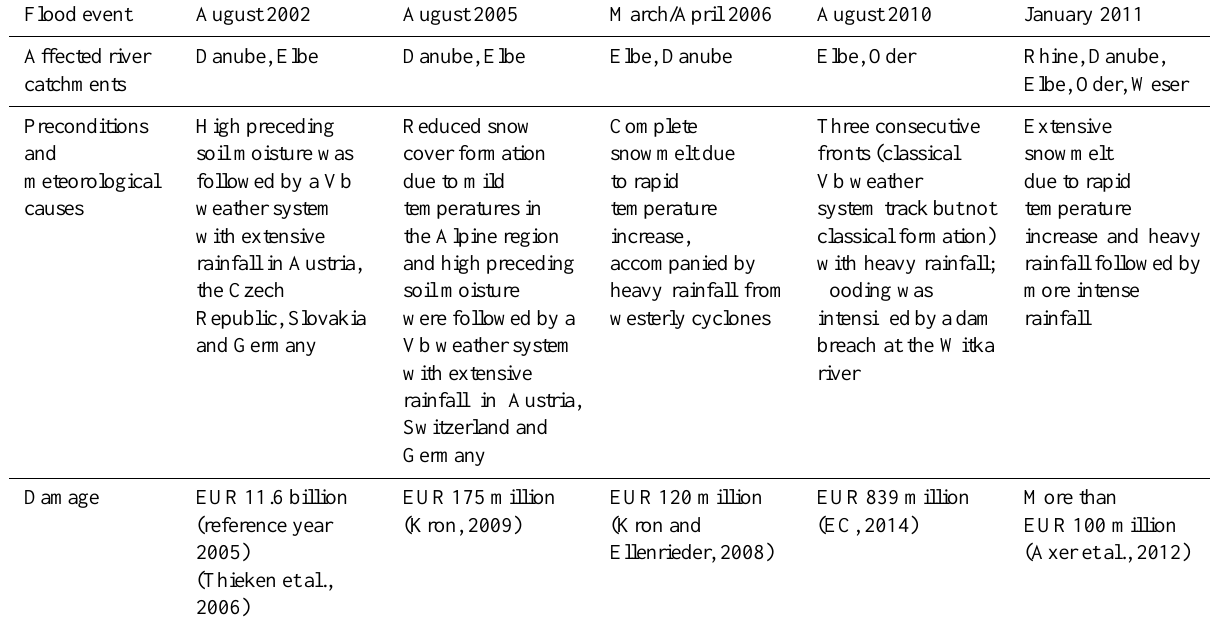
Table 1. Hydro-meteorological conditions and financial damage for the investigated flood events. Flood